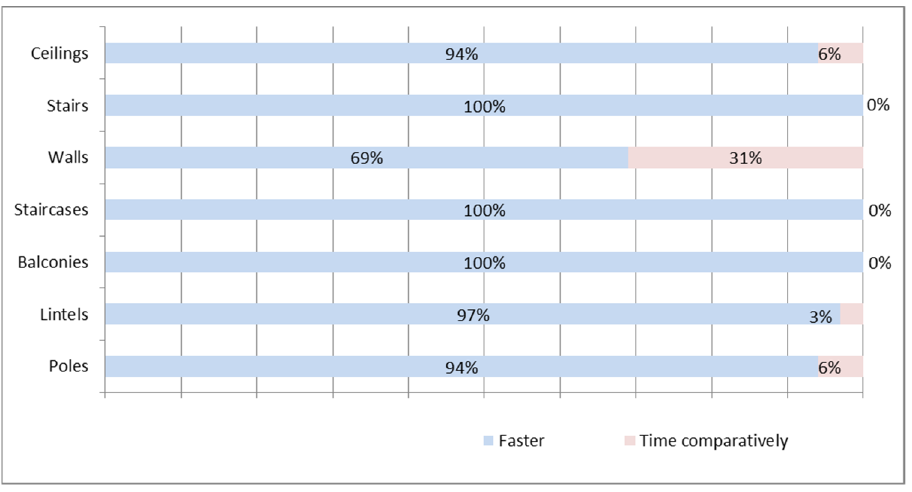
Figure 6. Implementation time—prefabricated technology and traditional technology—contractors.